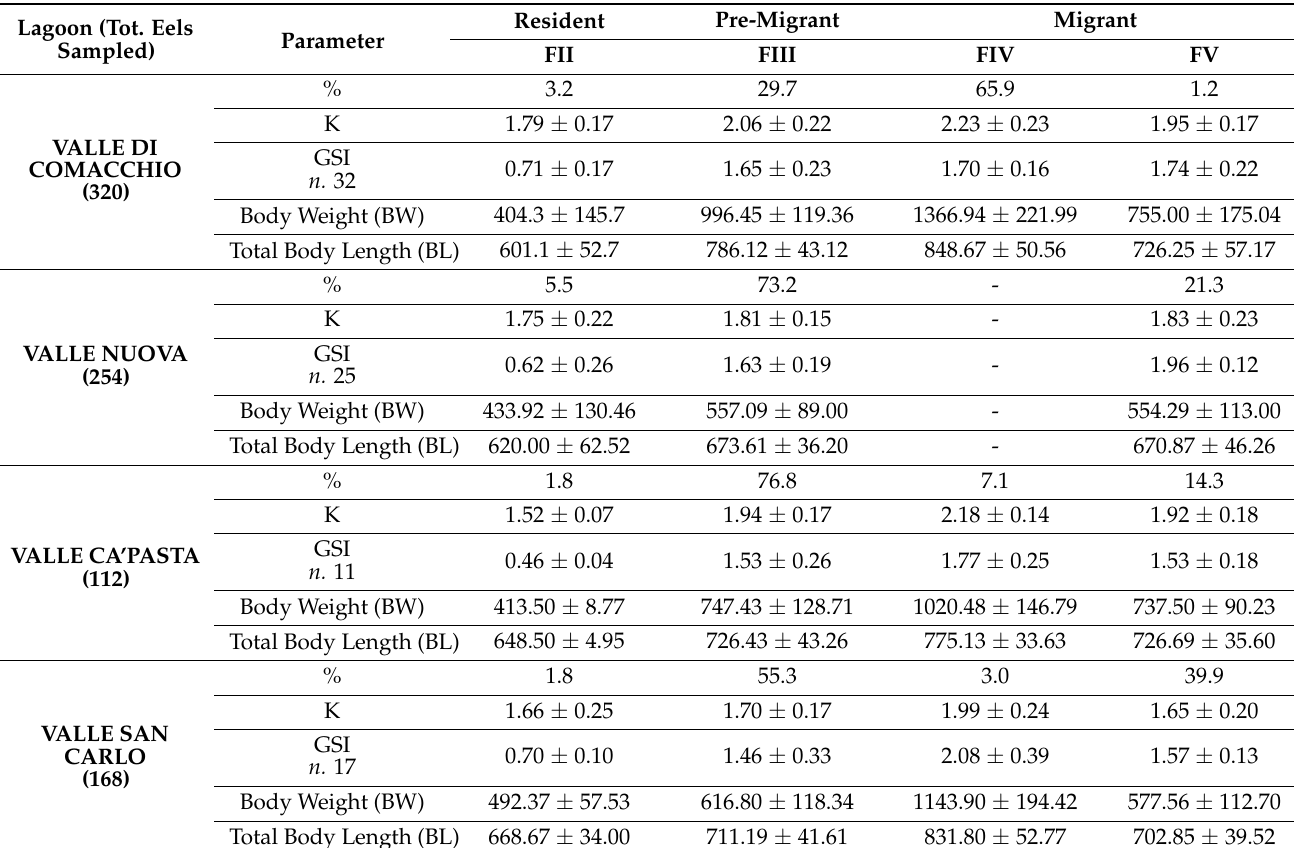
Table 2. Morphometric parameters and silvering indices of the four eel populations. Data are reported as mean ±